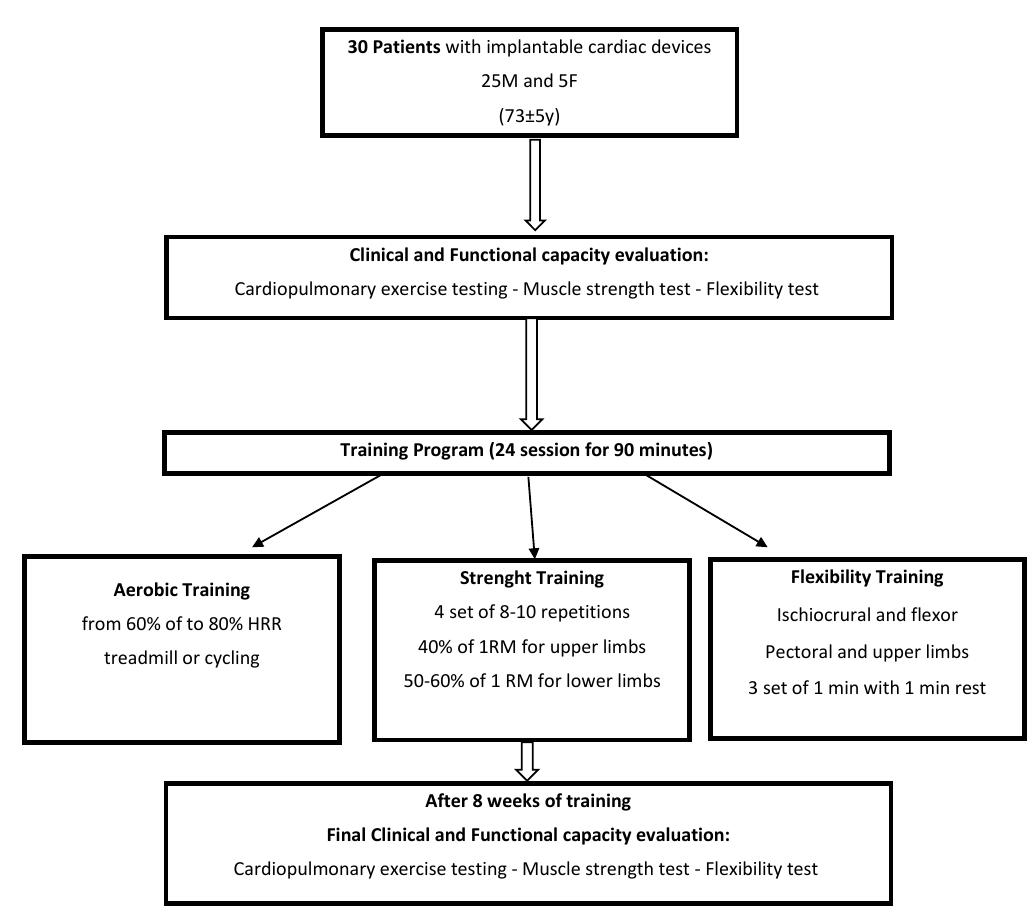
Figure 1. Training program of the patients studied.